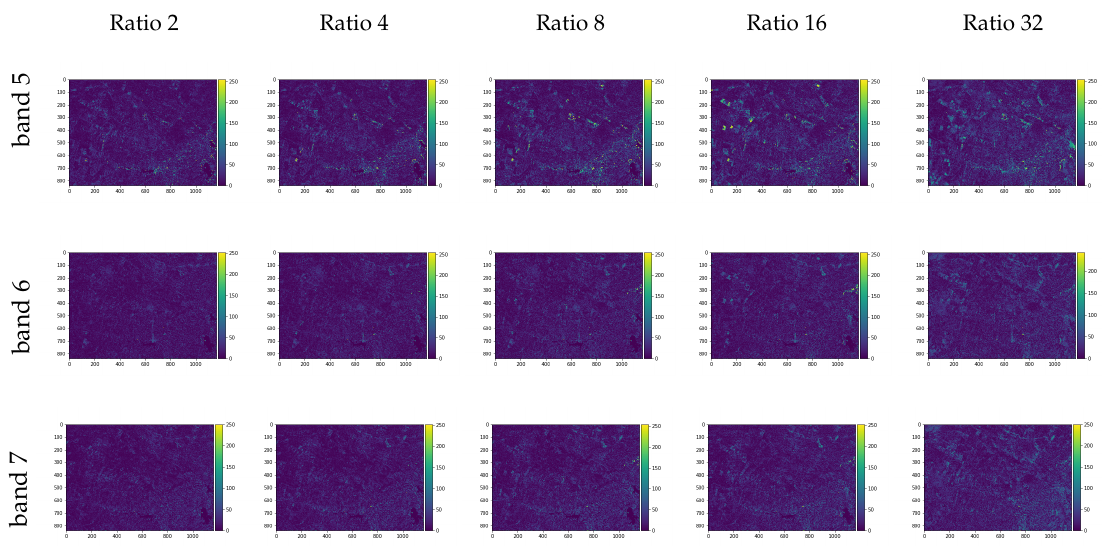
Figure 11. Image differences between the generated images and the original near-infrared (NIR) (band 5) and short-wave infrared (SWIR) (bands 6 and 7) for the Landsat image test